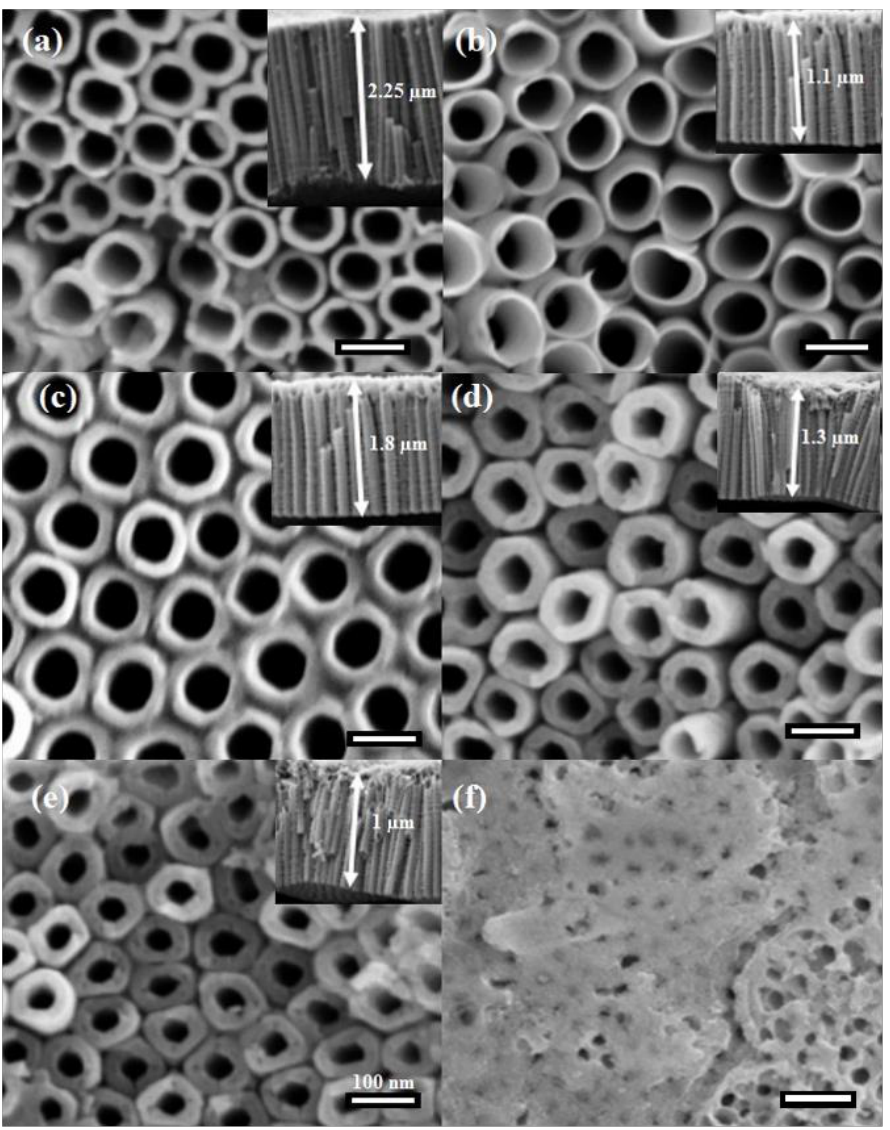
Figure 1. Top view SEM images of annealed nanotube arrays ( a ) pure TiO 2 , ( b ) Zn-doped TiO 2 , ( c ) Sr-doped TiO 2 , ( d ) Cu-doped TiO 2 (0.01 M), ( e ) Cu-doped TiO 2 (0.02 M), and ( f ) Cu-doped TiO 2 (0.03 M). The insets show cross-sectional SEM images of the samples. The scale bar is 100 nm. Top and cross-sectional SEM images of Sr-doped nanotubes are shown in Figure 1c. The average tube diameter, tube length, and tube wall thickness of Sr-doped nanotubes